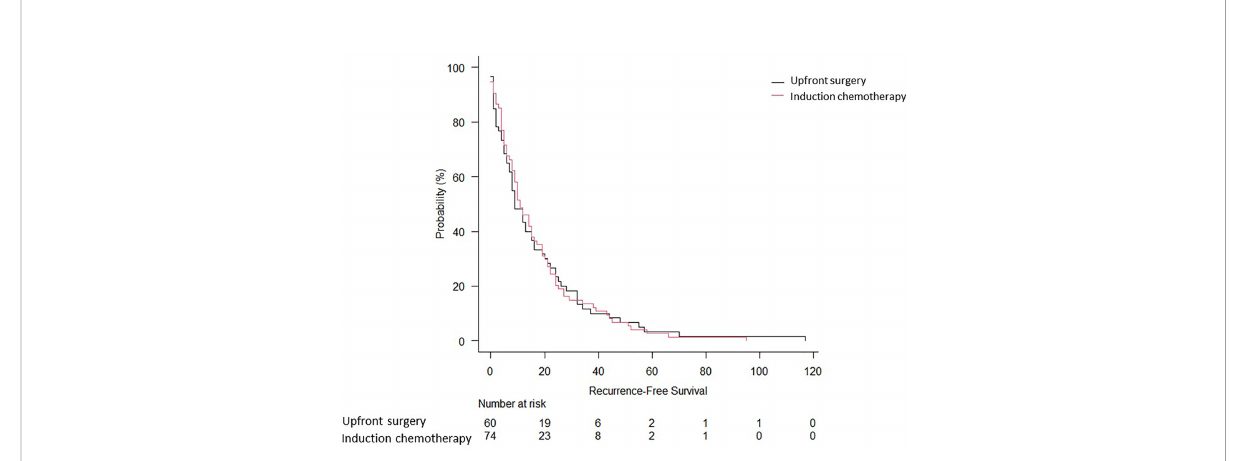
FIGURE 2 Overall survival of biopsy-proven N2 NSCLC patients who underwent upfront surgery or induction chemotherapy.